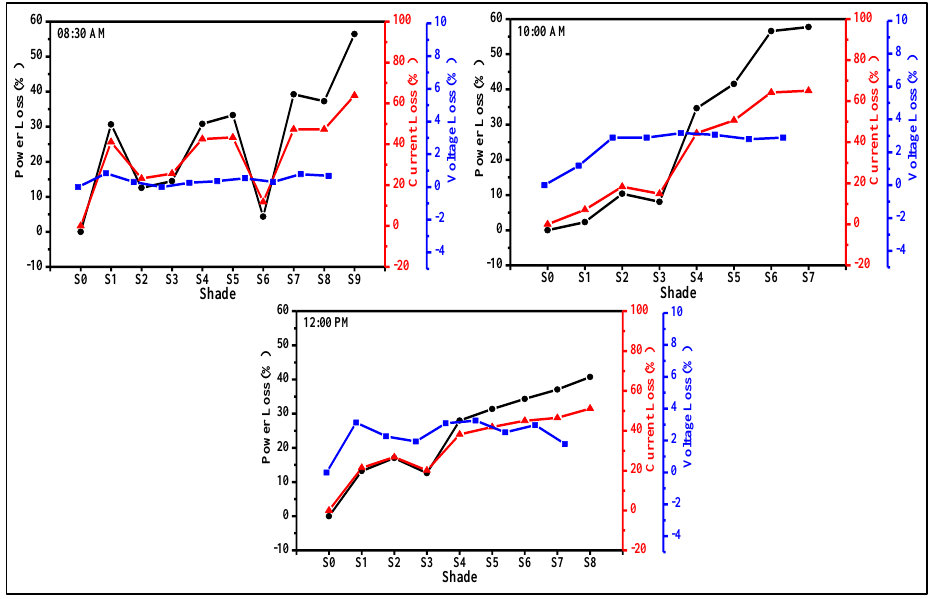
Figure 7. PV panel loss in Pm, Vm, and Im due to partial shade at 8:30AM,10:00AM, and 12:00PM. It is well-known that ambient temperature is a major suppressor for PV panel productivity, and it is also known that panel’s temperature is significantly higher than ambient temperature because PV panel surface is a perfect black colored absorber. The passing photocurrent also contributes in heating. Figure (8) shows the effect of ambient temperature on the productivity of a 230W PV